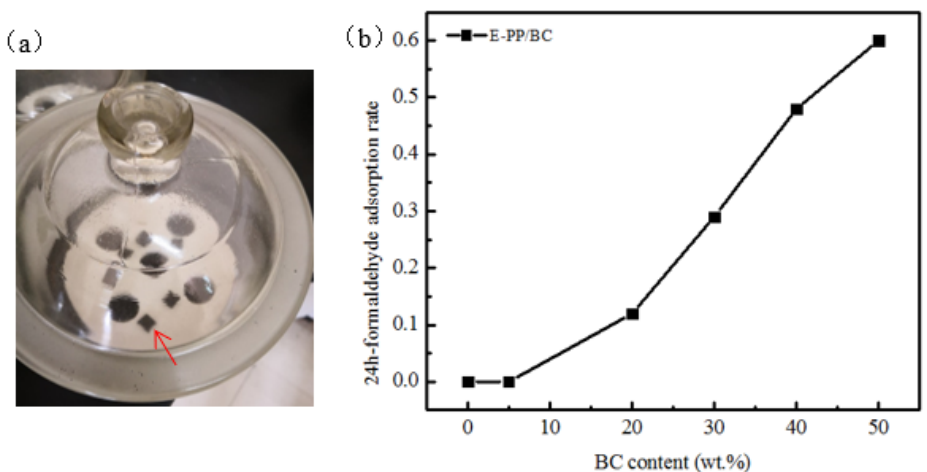
Figure 7. Formaldehyde adsorption testing and results: ( a ) formaldehyde adsorption testing desiccator, and ( b ) 24-h formaldehyde adsorption rate curves of the foamed E-PP/BC composites with different BC content.